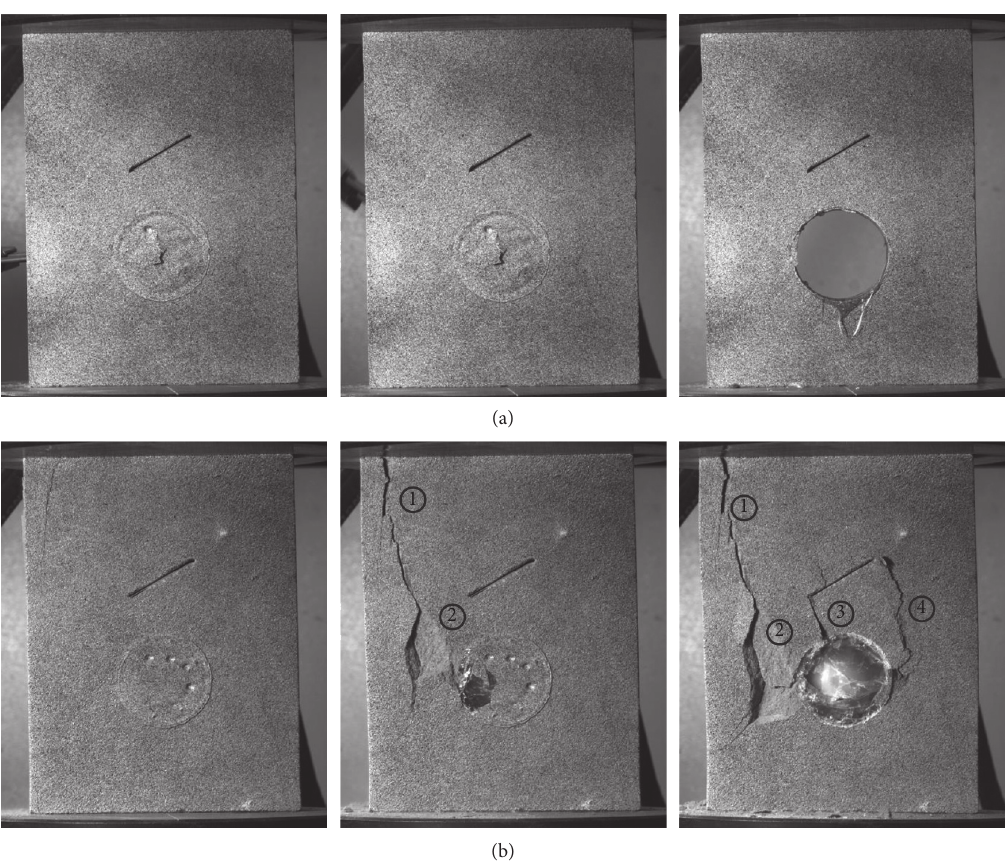
Figure 5: Crack evolution process of α � 30 ° : (a) S-30-80; (b) S-30-100.